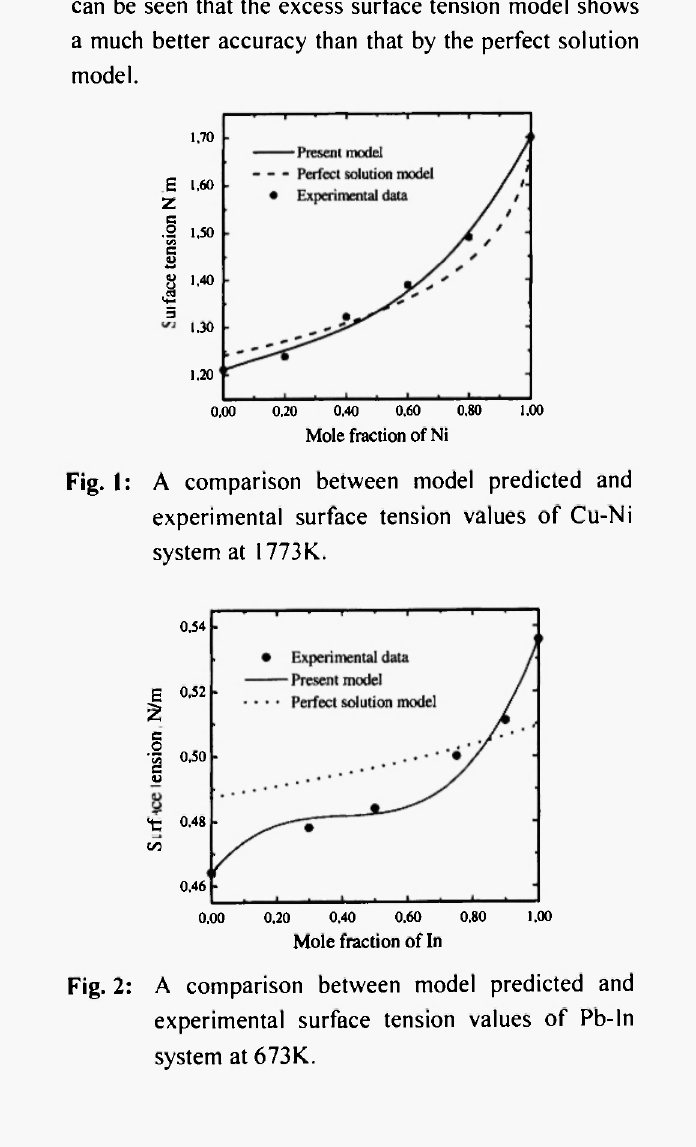
A comparison between model predicted and experimental surface tension values of Pb-Sn system at 1053 Κ.